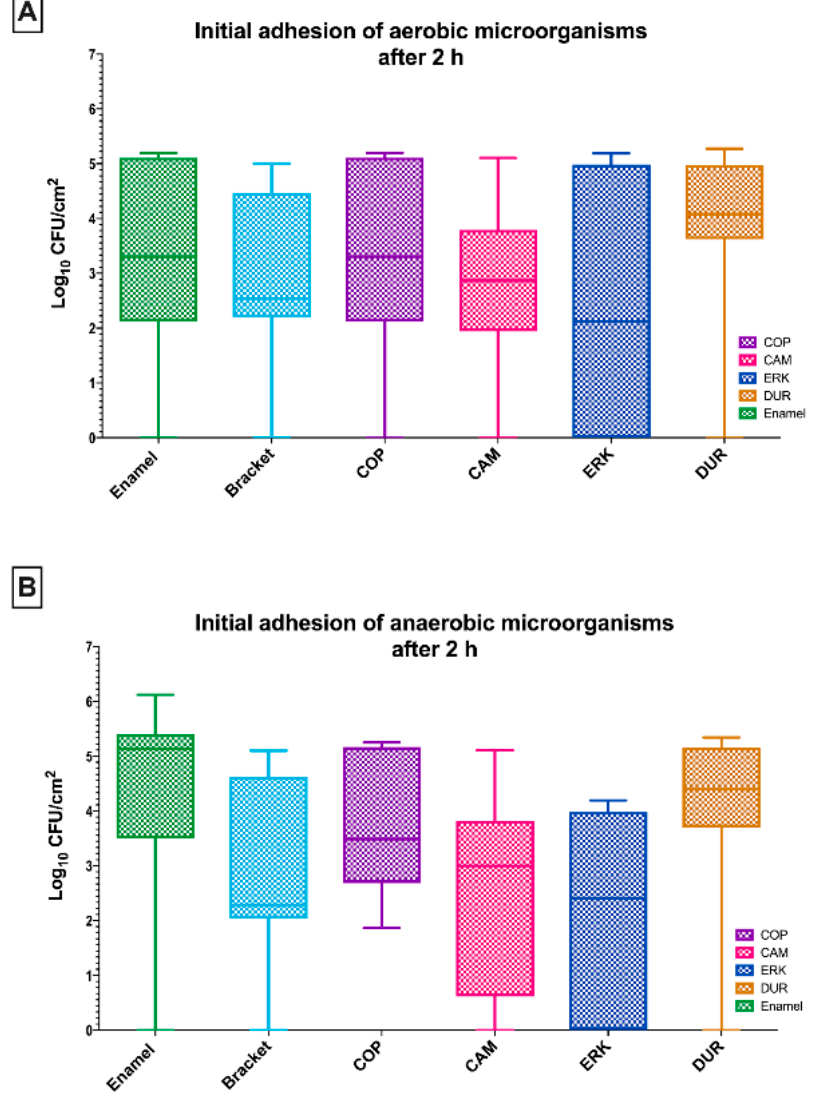
Figure 1. Boxplots depicting the colony-forming units (CFUs) of aerobic ( A ) and anaerobic ( B ) microorganisms on the tested aligner and control surfaces after an incubation time of 2 h. The medians, whiskers, and max/min outliers are demonstrated. Four different aligner materials were tested: CA-medium (CAM), copolyester (COP), Duran (DUR), Erkodur (ERK). Bovine enamel and metal brackets served as control groups.